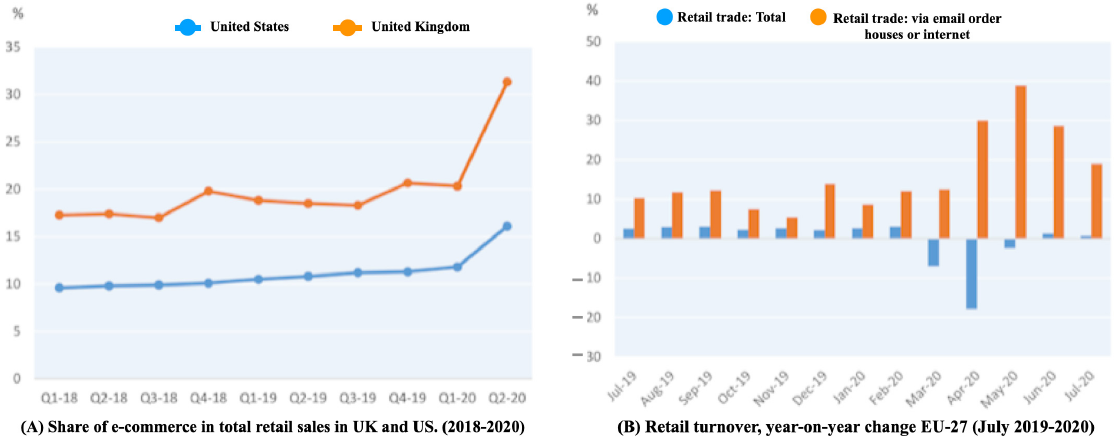
Figure 2. The increasing of e-commerce in total retail during the COVID-19 pandemic [11]. Author’s own elaboration from OECD figures (2020).